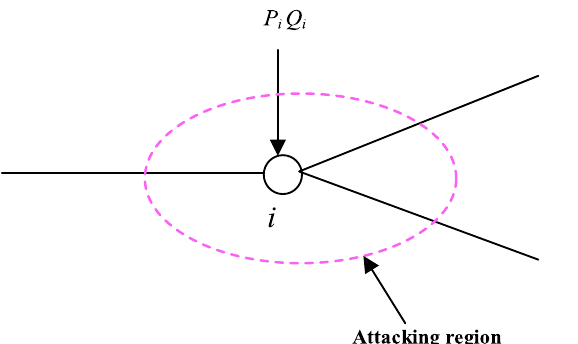
Fig. 4 A boundary bus in the attacking region